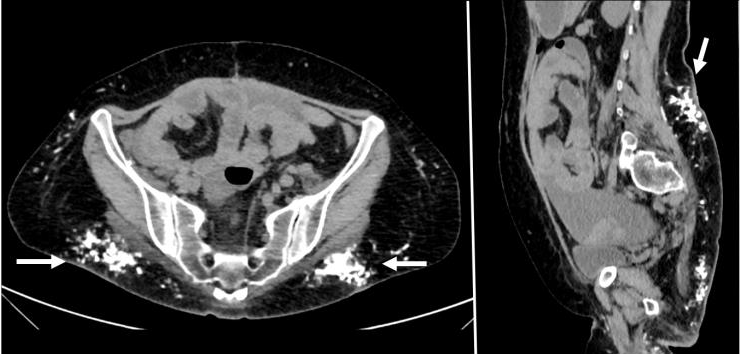
Figure 15. Woman with long-standing dermatomyositis. Axial and sagittal not-enhanced CT scan reveals diffuse, multiple calcifications on the subcutaneous abdominal tissue, representing the